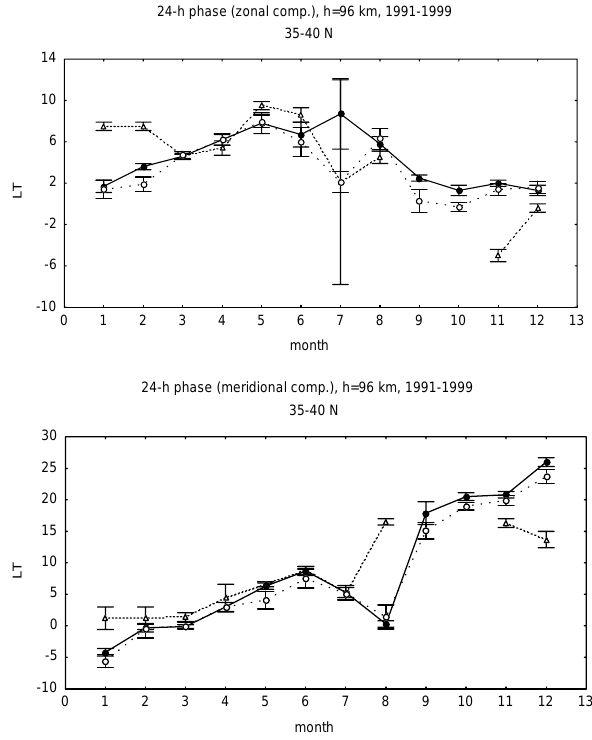
Fig. 4. Same as Fig. 2, except for phase of diurnal tide.